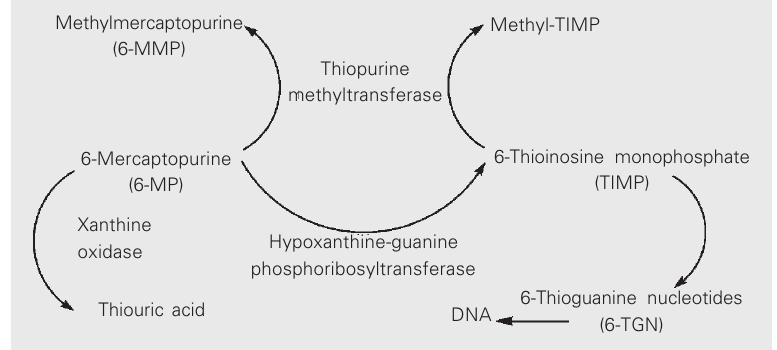
Figure 1. Schematic representation of the metabolism of 6-mercaptopurine (adapted from Refs. 10 and